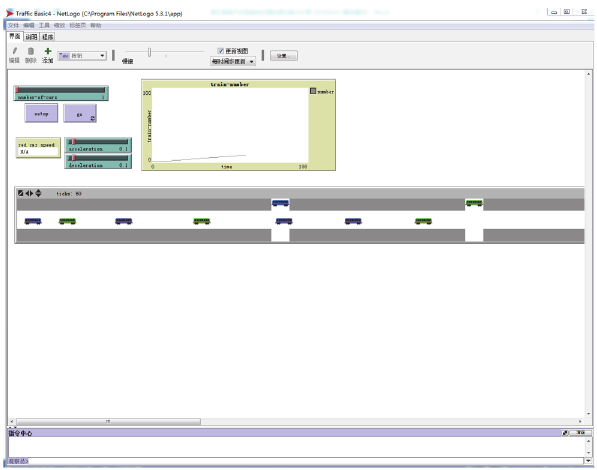
Figure 5: Simulation interface of the system.